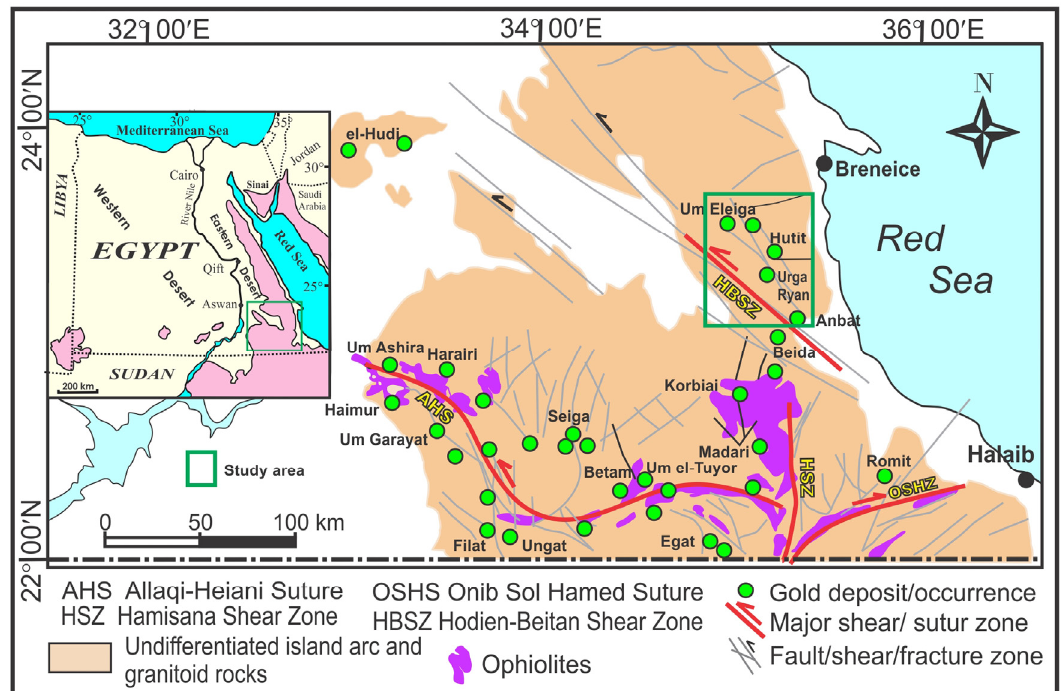
Figure 1. Distribution of the known gold mining sites and gold quartz vein occurrences relative to the major fault/shear structures and ophiolitic masses in the South Eastern Desert terrane (modified after [11]). Inset shows a location map of the study area.